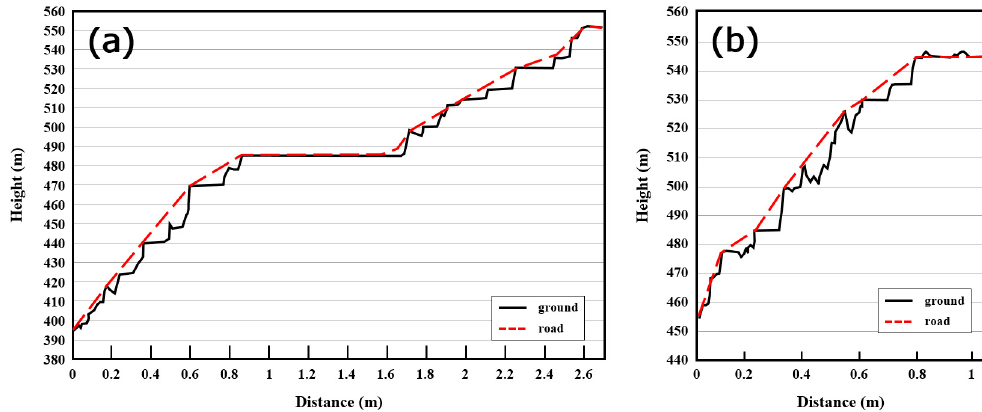
Fig 17. Figure 16. Results of analyzing the terrain profile (solid line) and designing the vertical layout (dashed line) of the haul road in ( a ) Pit 1 and ( b ) Pit 2.